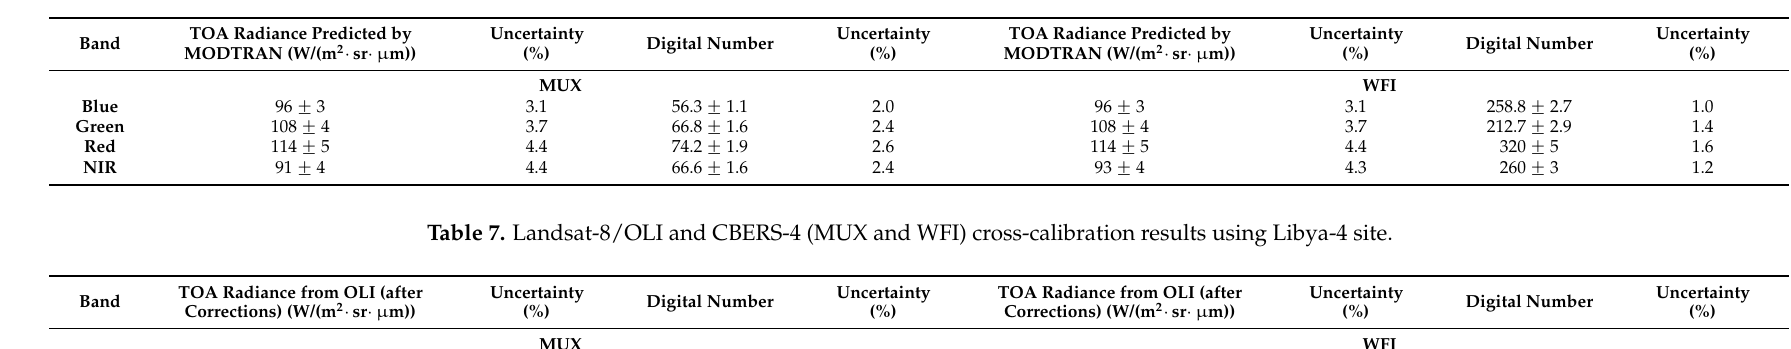
Table 6. Summary of reflectance-based approach results using Algodones Dunes site of 160 by 300.